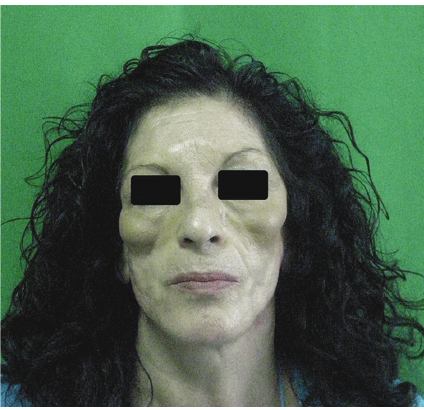
Figure 1: Initial condition of the patient.